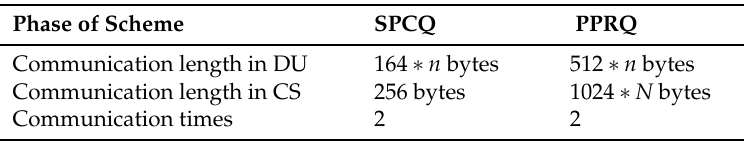
Table 3. Comparison of communication